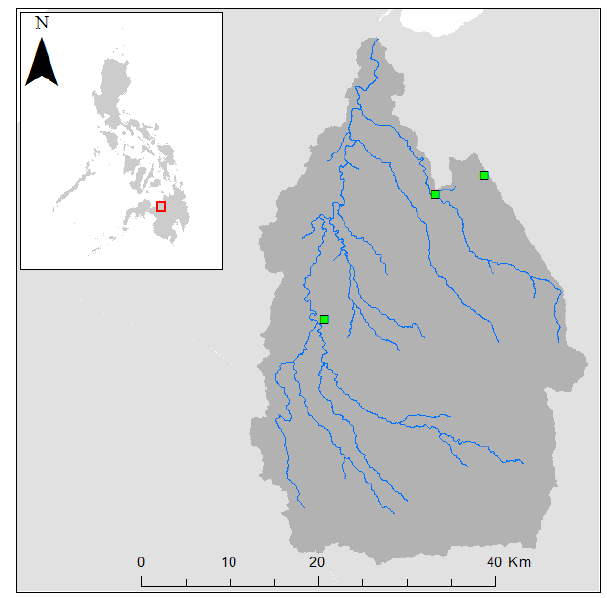
Figure 1. The Cagayan de Oro watershed and rain gauges relative to the Philippines.